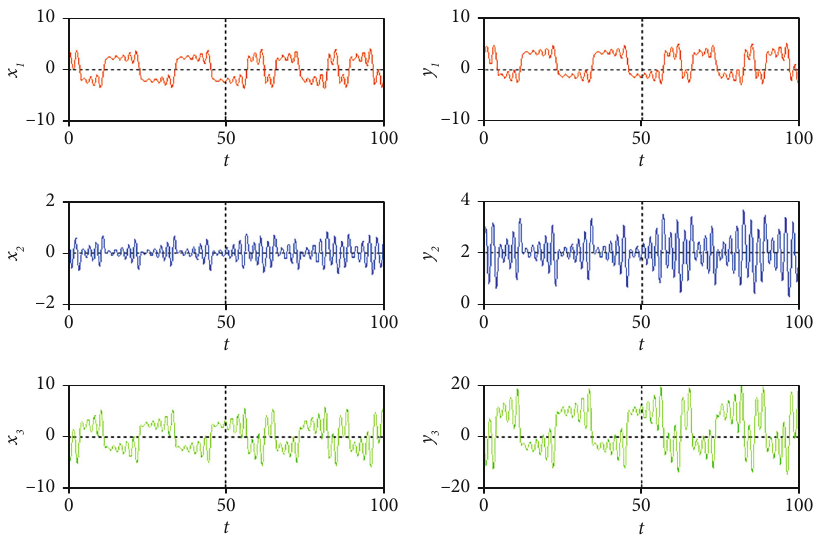
Figure 11: Time histories of di ff erent state variables in the unidirectionally coupled Chua ’ s circuit with the linear manifold y = Px + Q